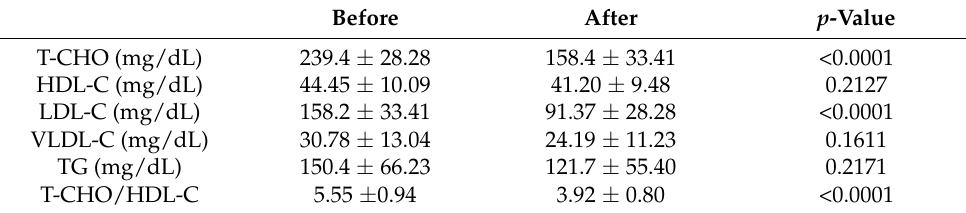
Table 2. Lipid profile before and after a 4-week atorvastatin treatment in hypercholesterolemic patients. Before After p -Value T-CHO (mg/dL) 239.4 ± 28.28